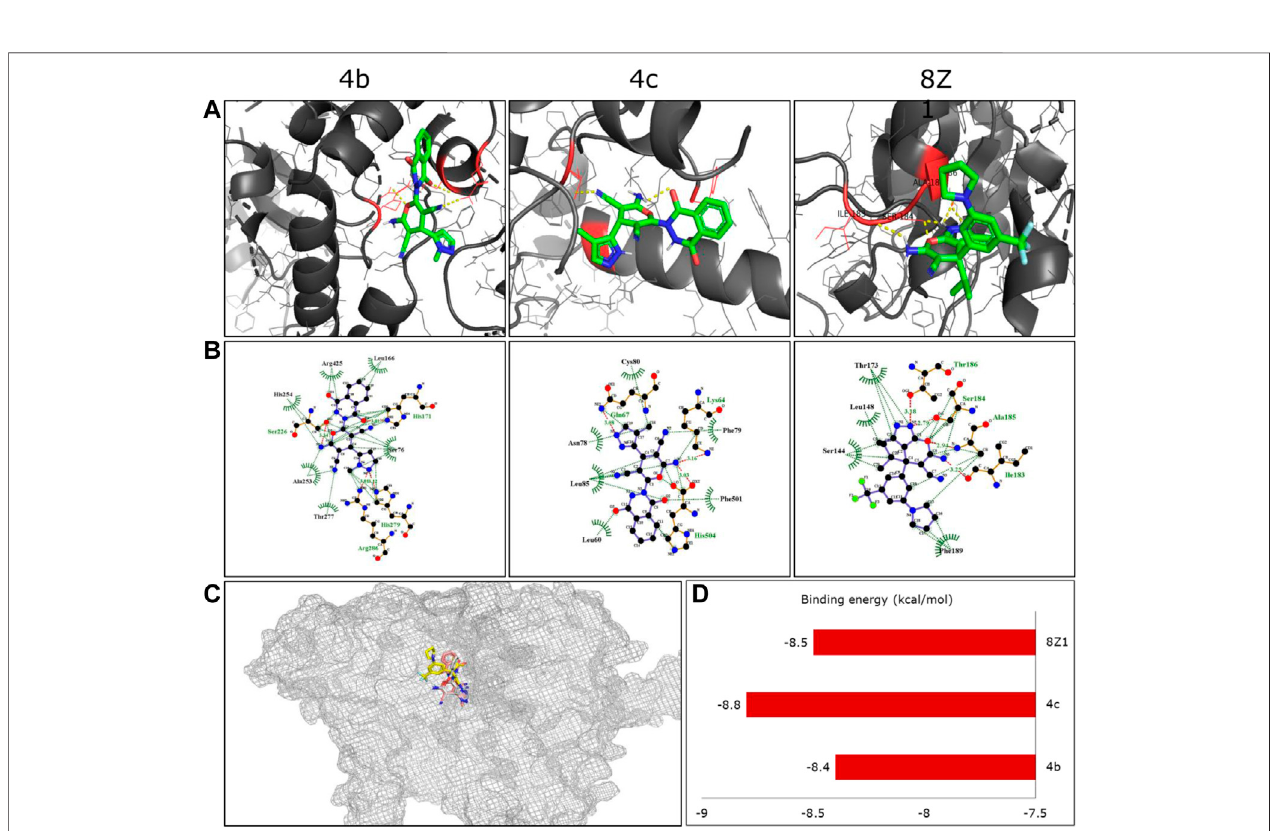
FIGURE 3 | (A) Three-dimensional binding conformations of the synthesized molecules against human serine hydroxymethyltransferase 2 protein (PDB ID: 5V7I). The yellow color dotted lines represent the hydrogen bonds as well as polar interactions. (B) Two-dimensional binding interactions of the docked ligand molecules with targetprotein. (C) Overlappedstructuresofthesynthesizedcompoundsalongwiththeco-crystalizedligandintheproteinactivesite. (D) Thebindingenergies(kcal/mol) of the docked compounds with target protein.